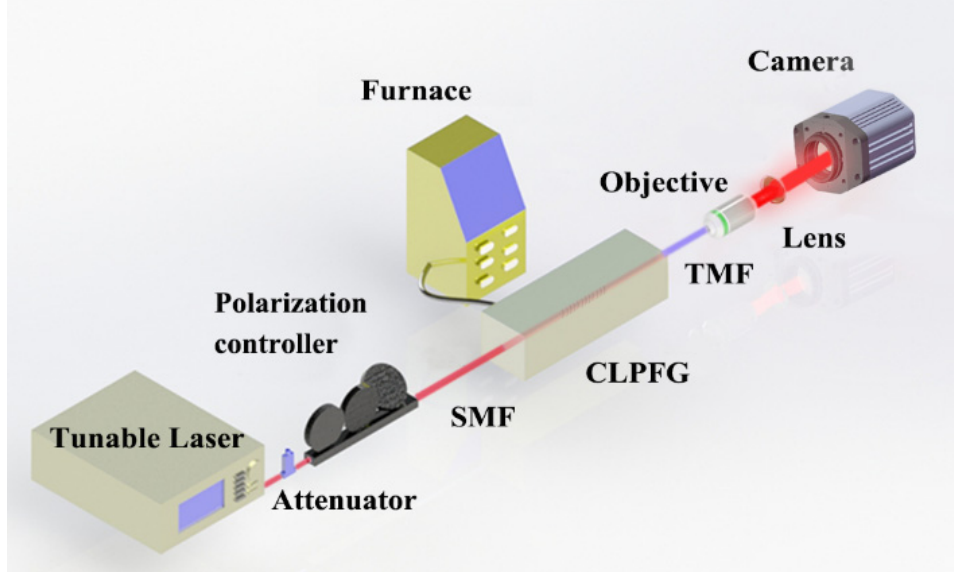
Figure 4. The experiment system of temperature measurement.